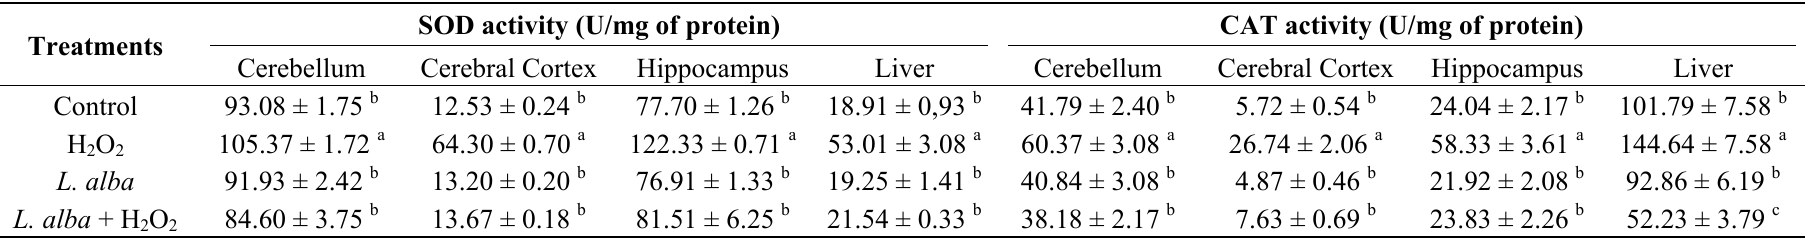
Table 6. Superoxide dismutase (SOD) and catalase (CAT) activities in rat cerebellum, cerebral cortex, hippocampus and liver cells treated with L. alba .